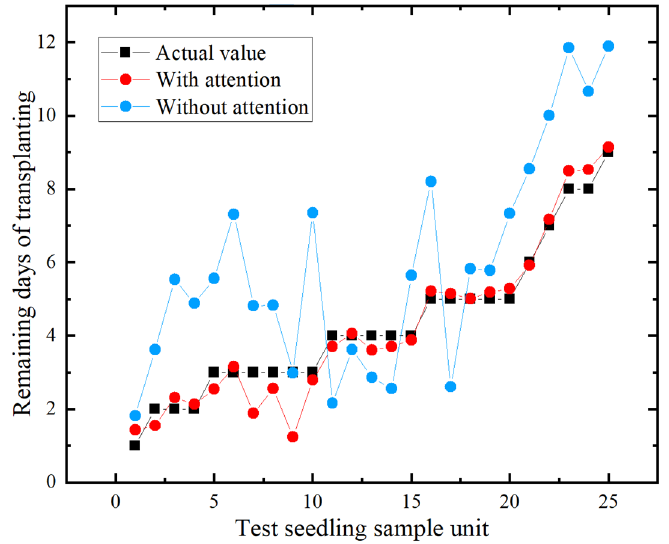
Figure 7. Effect of the attention mechanism on the prediction results. The horizontal axis represents the seedling sample unit of the test set, and the vertical axis represents the remaining transplanting time. The black rectangles represent the actual values, the red dots represent the predicted values with the attention mechanism added to the model, and the blue dots represent the predicted values without the attention mechanism added to the model.